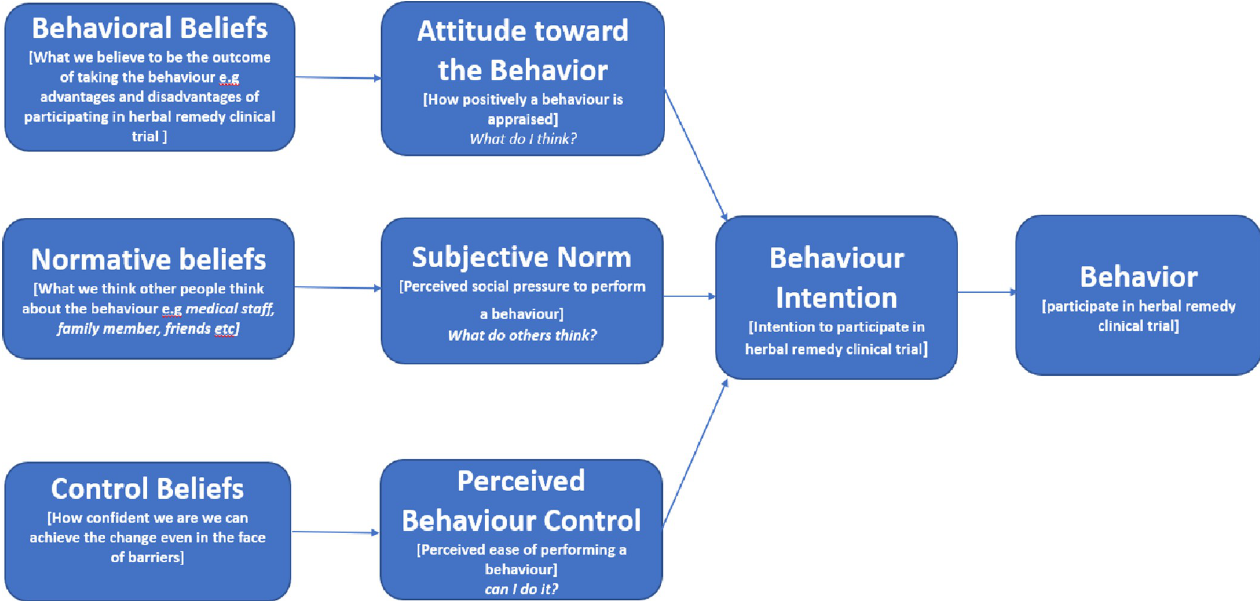
Fig 1. Application of the theory of planned behaviour model to investigate attitude, subjective norm, and perceived behaviour control in determine healthy participants’ participation in herbal remedy clinical trial. Adapted from Ajzen